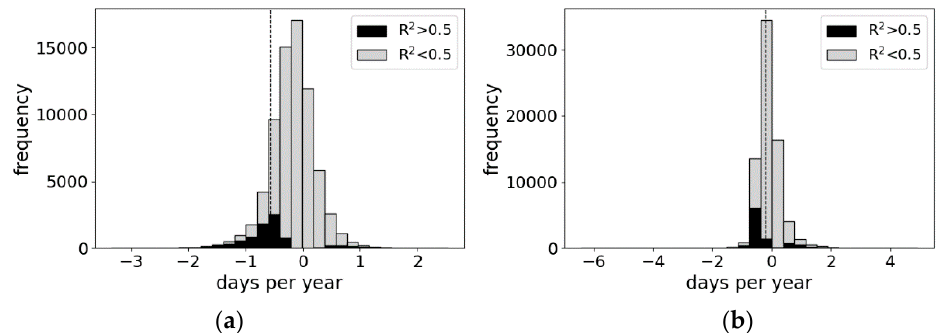
Figure 11. The rate of change observations for ( a ) start and ( b ) end day of melt. The dashed line shows the mean value of the observations for which R 2 is larger than 0.5.